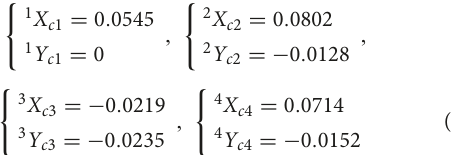
body, and the center of mass c 4 of the Connecting rod 2 relative to the X - Y plane of the { 1 } , { 2 } , { 3 } , { 4 } coordinate